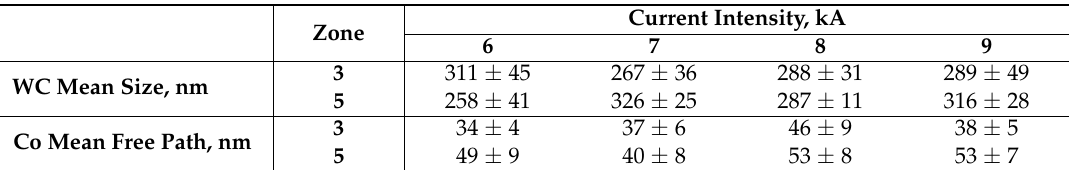
Table 1. Effect of current intensity on WC mean grain size and Co mean free path at zones 3 and 5, measured along a line perpendicular to the pressing direction. Sintering time was 600 ms.